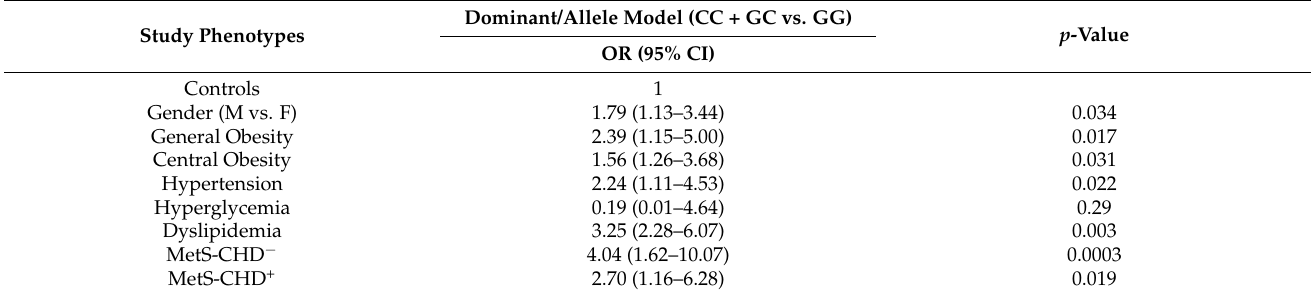
Table 2. Genetic association of rs1333049 SNP with cardiometabolic risk phenotypes. Study Phenotypes